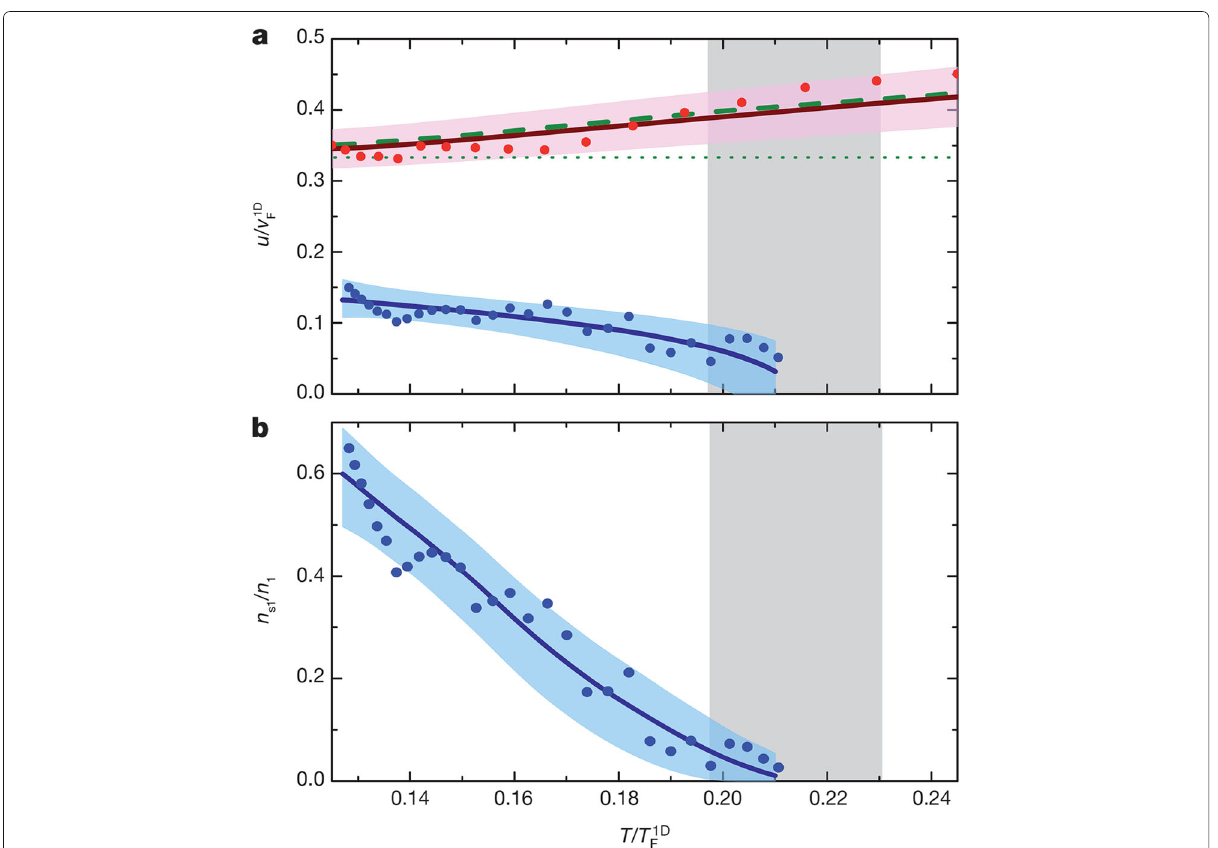
. The solid lines and symbols are F √ 7 P 1 /( 5 mn 1 ) .